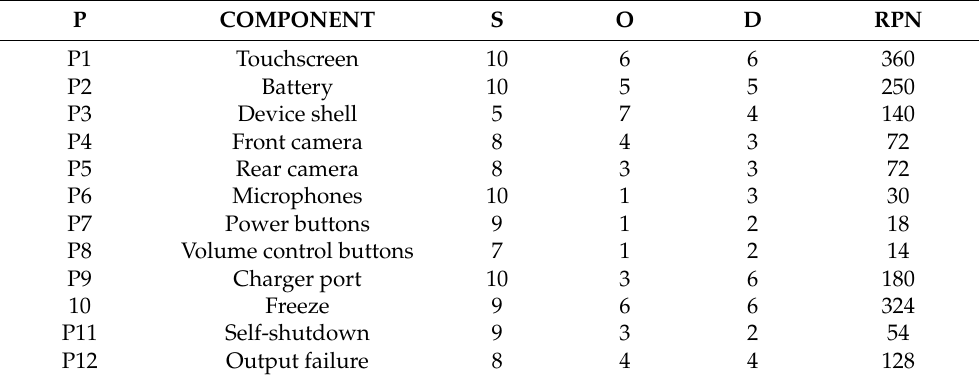
Table 2. Collection of S, O, D, and RPN values from the 1st team. P